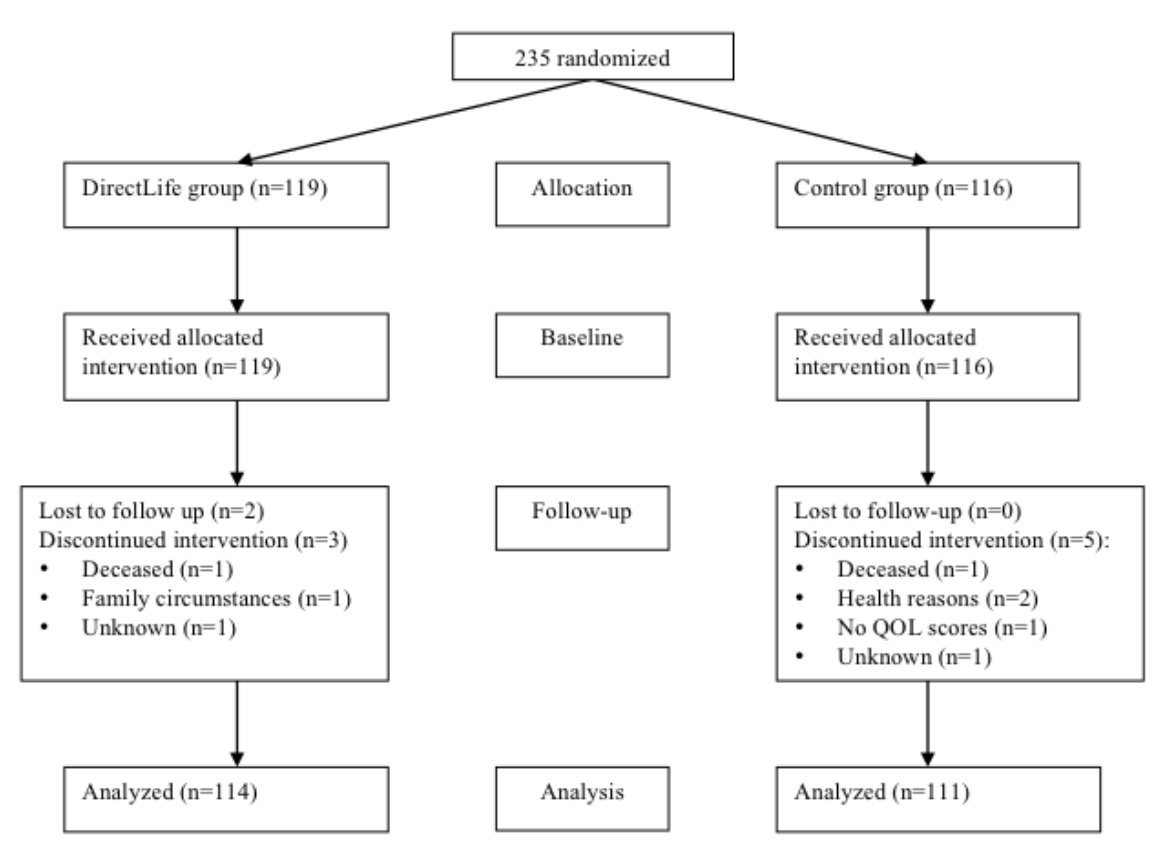
Figure 1. Flowchart of participants. QOL: quality of